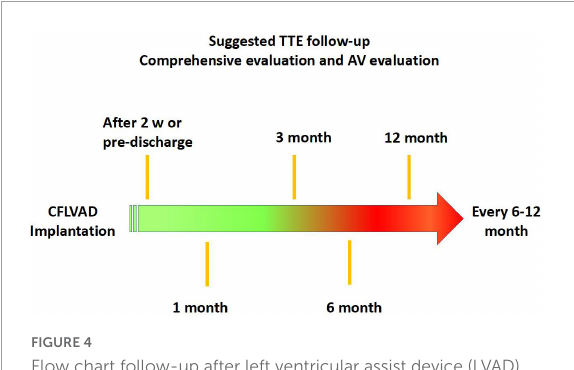
FIGURE4 Flow chart follow-up after left ventricular assist device (LVAD)